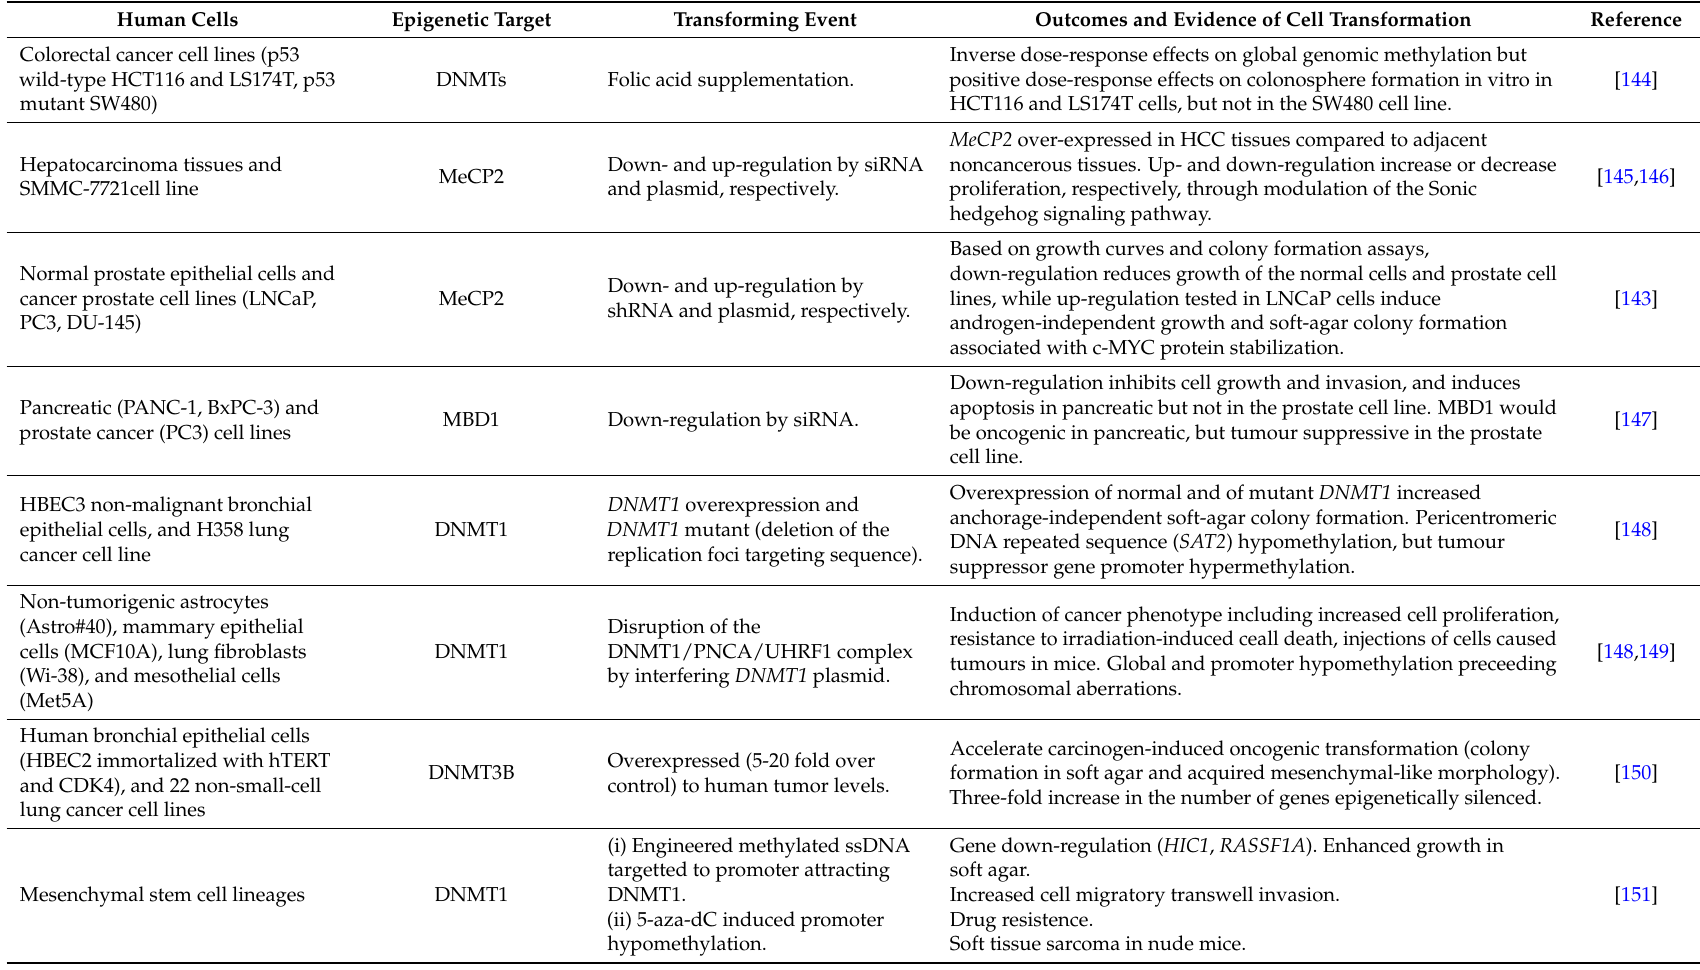
Table 4. Study examples demonstrating that modulating the expression of DNA methylation “readers”, “writers”, or “editors/erasers” leads to adverse oncogenic events in human